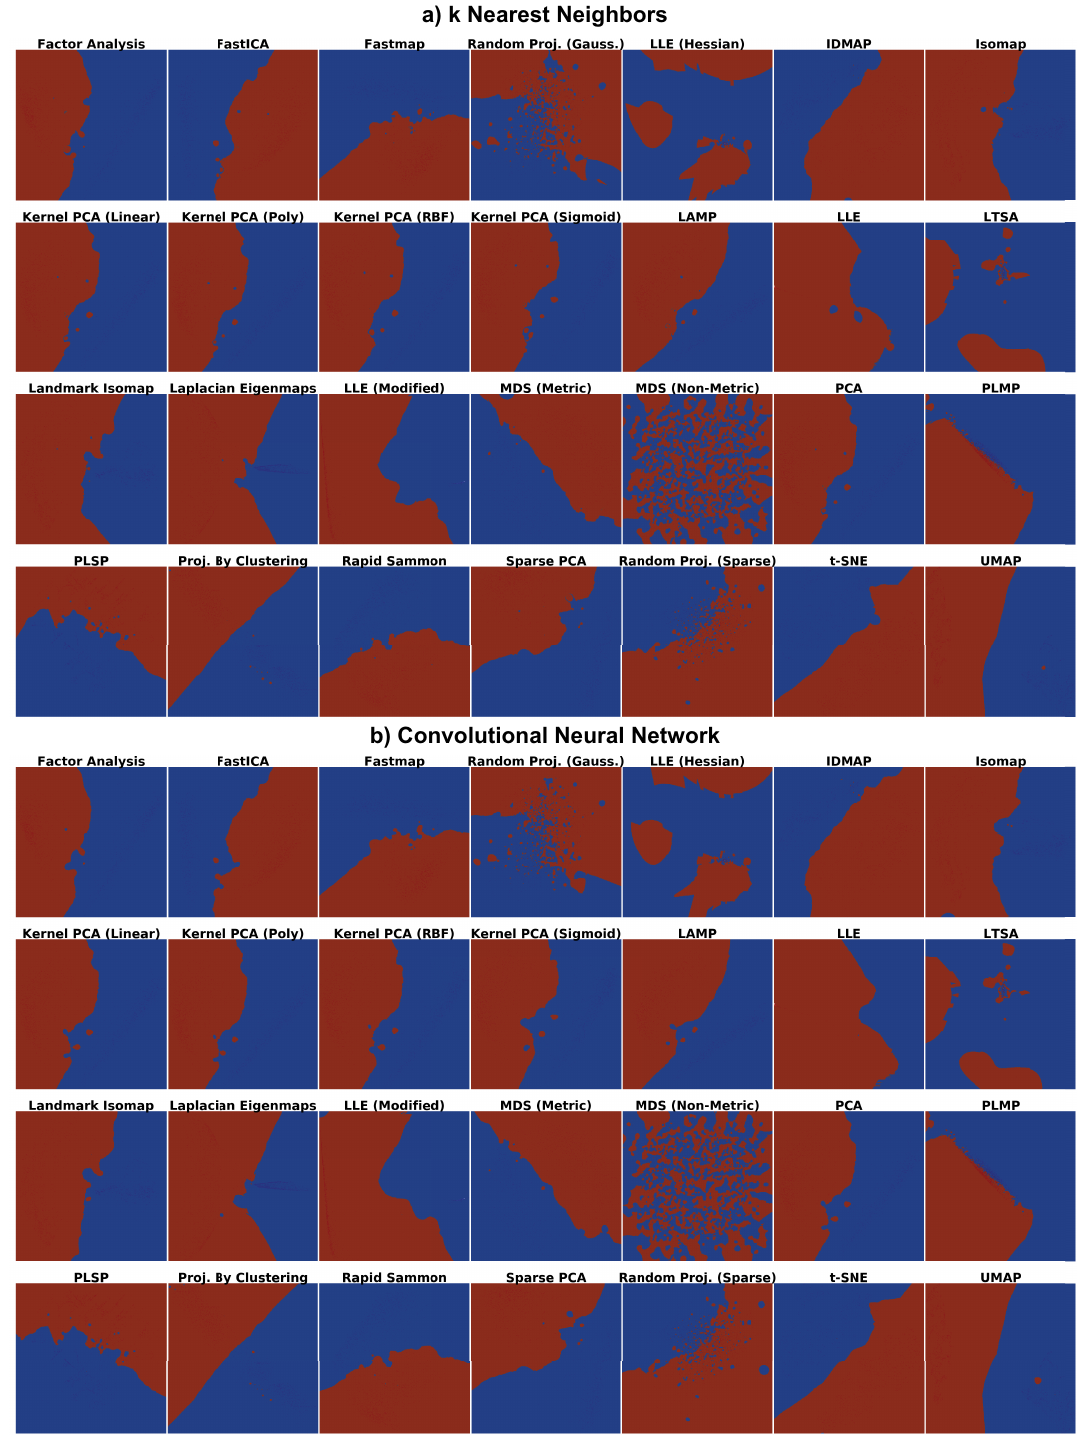
Figure 3. Dense maps for k-Nearest Neighbor (k-NN) ( a ) and Convolutional Neural Network (CNN) ( b ) classifiers on the 2-class S 2 dataset, all 28 tested projections. Islands: The dense maps in Figure 4 show many small color islands . An island indicates that (at least) one sample was assigned a label different from the labels of samples that project close to it. In turn, this means that